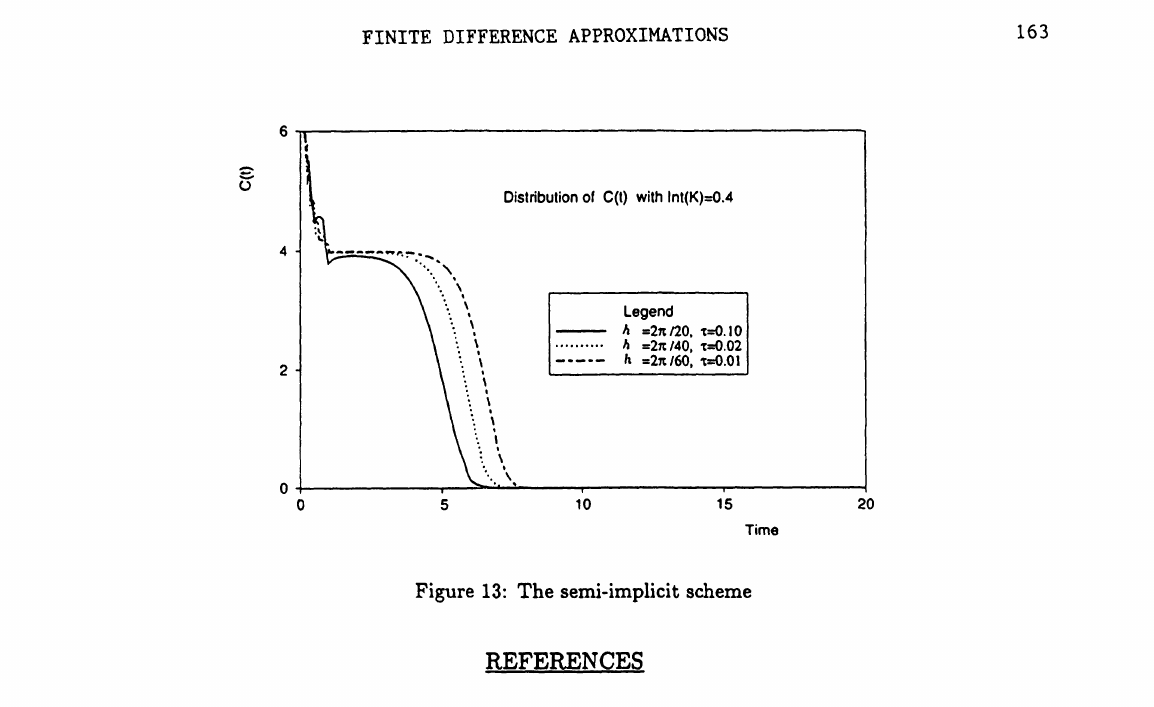
Figure 13: The semi-implicit